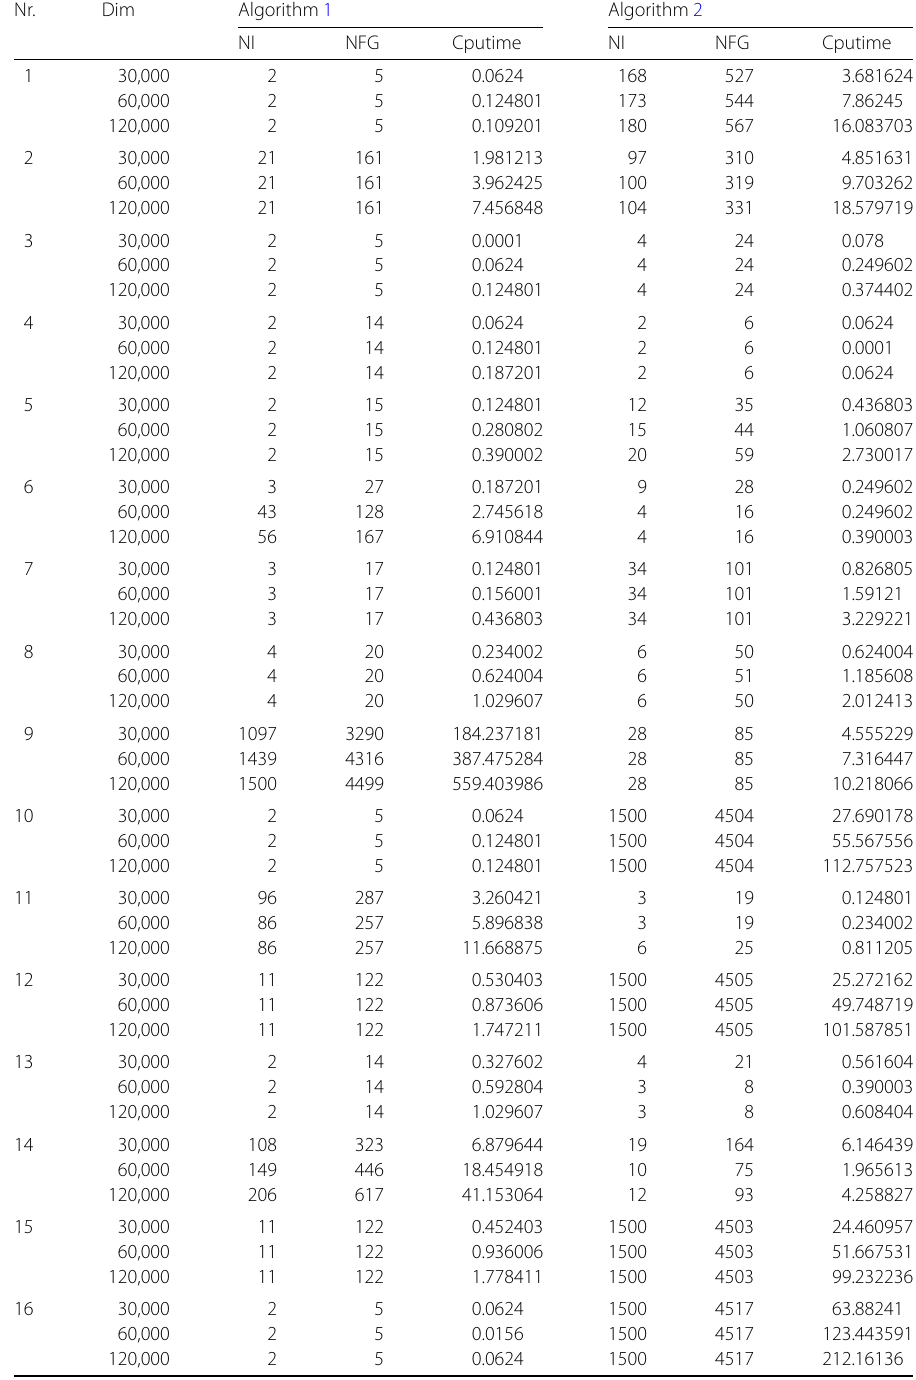
Table 2 The numerical results of Algorithm 1 and Algorithm 2